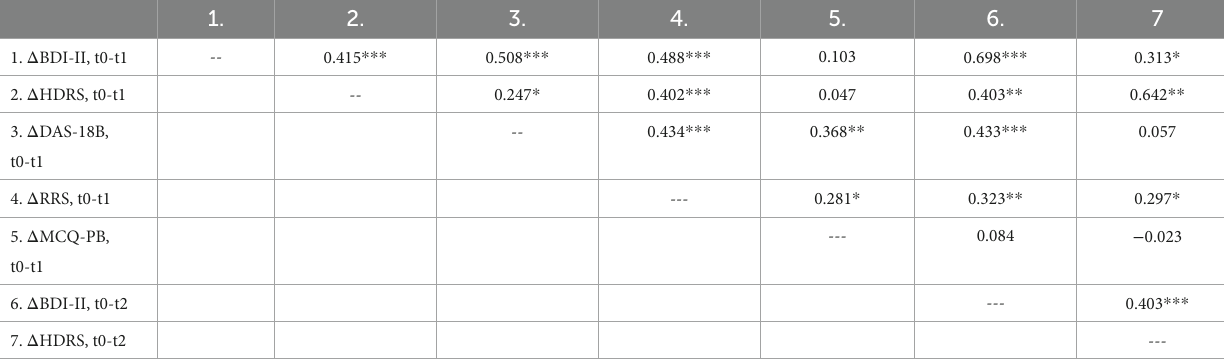
TABLE 2 Pearson’s correlations between change in self-reported and clinician-rated depression with change in negative cognitive beliefs, positive metacognitive beliefs and rumination ( N = 66).